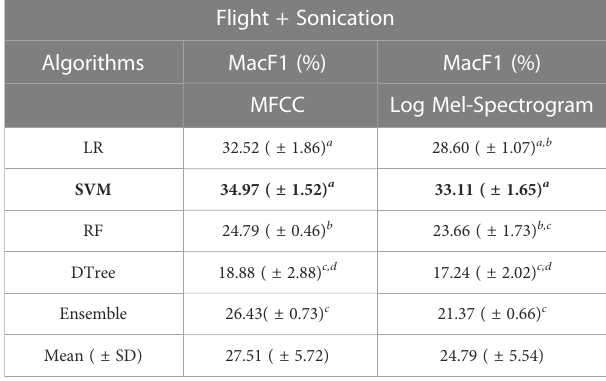
The performances of the classical ML algorithms were measured by Macro-F1 score (MacF1) ( ± standard deviation). Bold numbers represent the best results per evaluation metric within audio feature extraction technique. Different superscript letters denote signi fi cant differences in F1-score among algorithms ( p ≤ 0 : 05, 5 (cid:2) 2 cv Combined F